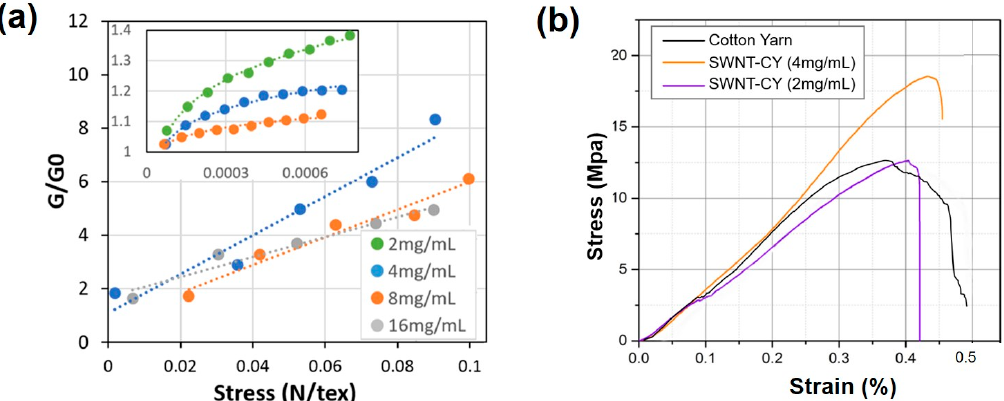
Figure 5. ( a ) The relationship between the conductance of SWNT-CYs (relative change, G/G0) and the tension applied to the SWNT-CYs dipped in SWNT solutions of different concentrations. The “tex” is a unit of textile measurement, which is defined as the mass in grams per 1000 m, i.e., describes the linear mass density of fibers. The inset data-plot shows the relationship between these two values when the stress is below 0.001 N/tex; ( b ) Stress-strain curves of cotton yarn (black line) and SWNT-CYs (yellow line, 4 mg/mL; purple line, 2 mg/mL) in the fracture tests. The relative rate of change of conductivity with respect to tension is greater for the single SWNT-CYs modified with a lower concentration of the SWNT solution (4 mg/mL) than for the single SWNT-